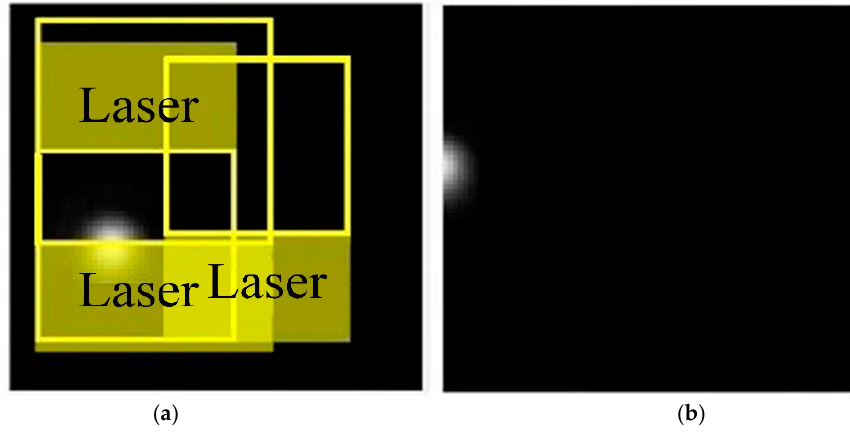
Figure 4. ( a ) Complete light spot map positioning (25 positive samples); ( b ) incomplete light spot map positioning (25 positive samples).